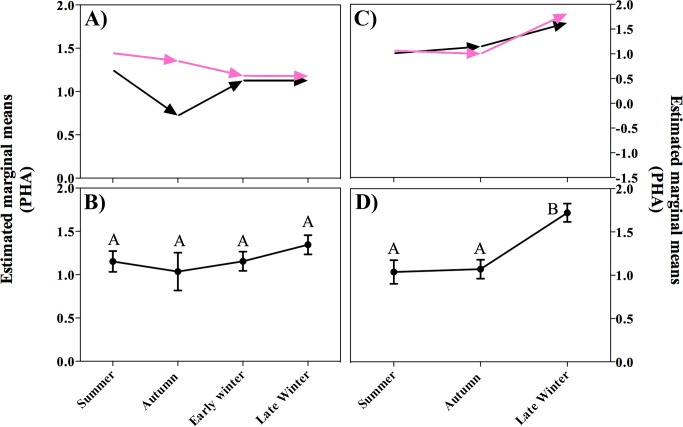
Seasonal swelling response after 12 hours of PHA injection.A) Data separated by sex from P1. B) Combined data from P1 (estimated marginal mean ± SE). C) Data separated by sex from P2. Pink arrows represent seasonal variation in the swelling response in females; black arrows represent seasonal changes in swelling response in males. D) Combined data from P2 (estimated marginal mean ± SE); different letters indicate significant differences among seasons.